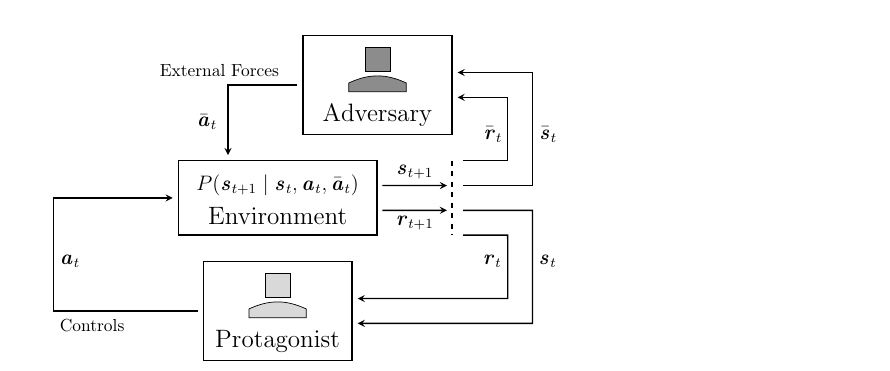
Figure 6. Illustration of the underlying concept of disturbance robust designs. Uncertainties in the system dynamics are modeled as disruptive forces. These forces represent an additional condition on the transition probabilities. As such, the transition function shifts according to the adversarial action to produce worst possible outcomes for the protagonist.